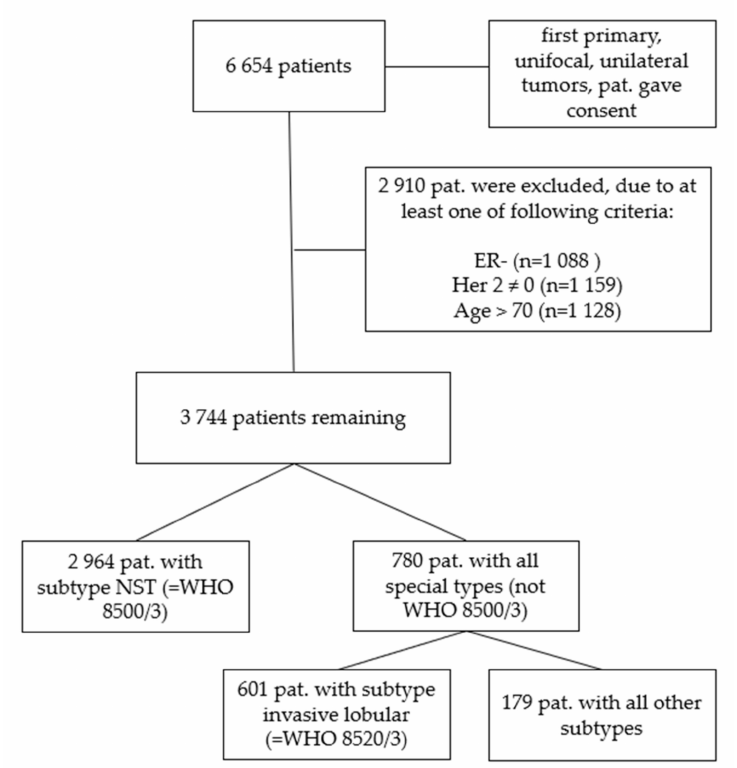
Figure 1. Consort diagram of the patient cohorts. First, all 6654 patients who gave consent with first primary, unifocal and unilateral tumors were analyzed, in step 2 the cohort was subdivided into ER-positive, Her2-negative cases with patients ≤ 70 years of age ( n = 3744). In a third step only patients with a histological subtype of NST (WHO 8500/3) were evaluated ( n = 2964). In a fourth step all remaining cases except NST (all other subtypes, not WHO 8500/3) were analyzed ( n = 780) and in a final step all invasive lobular (WHO 8520/3) tumor cases ( n = 601) separated from all other remaining subtypes ( n =